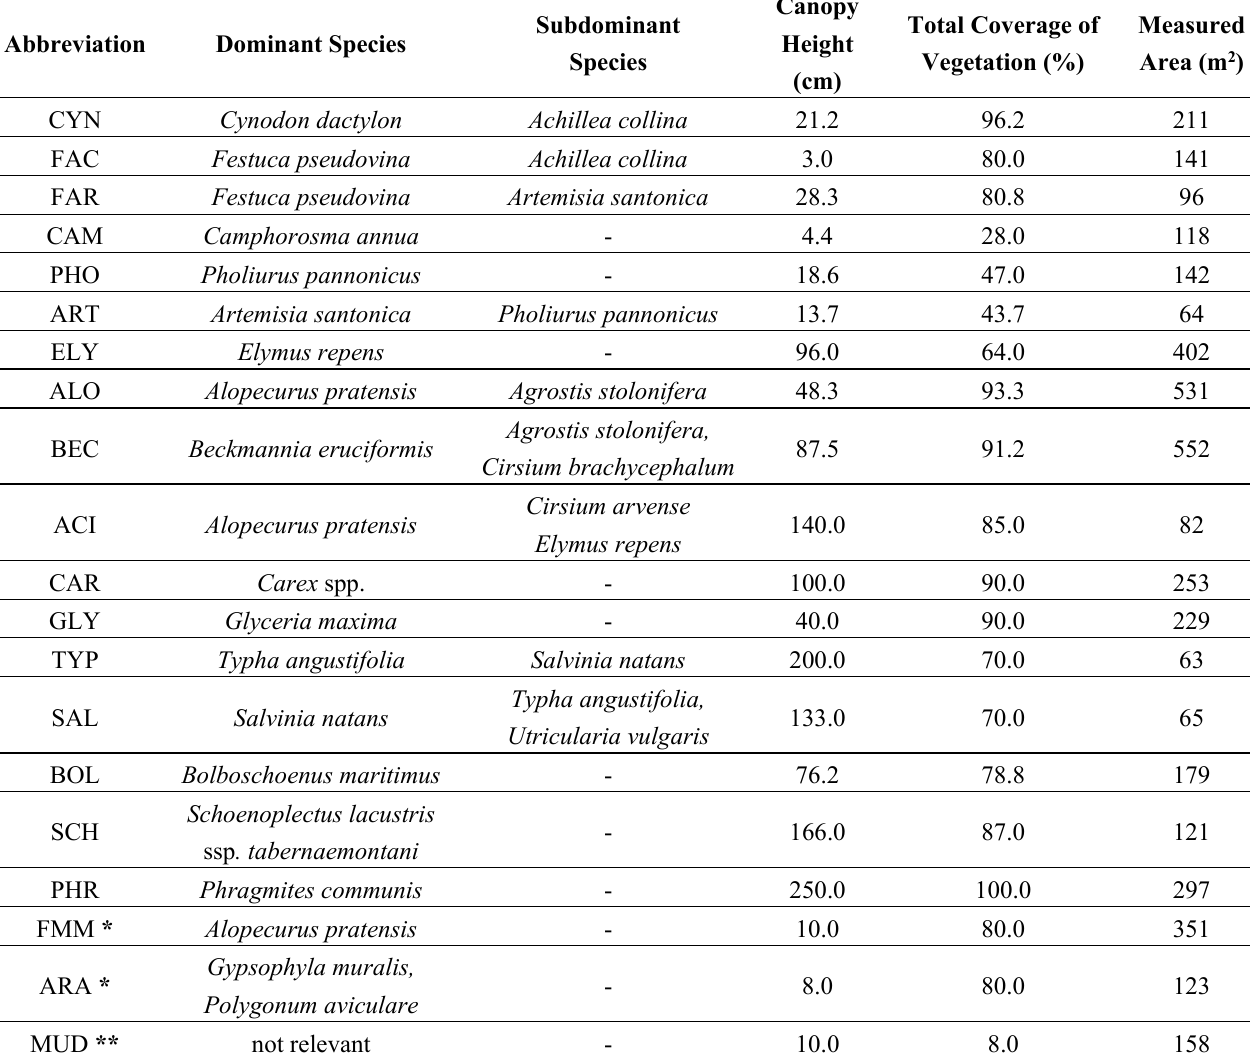
Table 1. Attributes of the studied vegetation classes. Dominant, subdominant species, mean canopy height, and mean total coverage of vegetation ( vs. open soil surfaces) are based on field measurements. * classified by land use type; ** classified by the high cover of bare muddy soil. One square meter corresponds to one